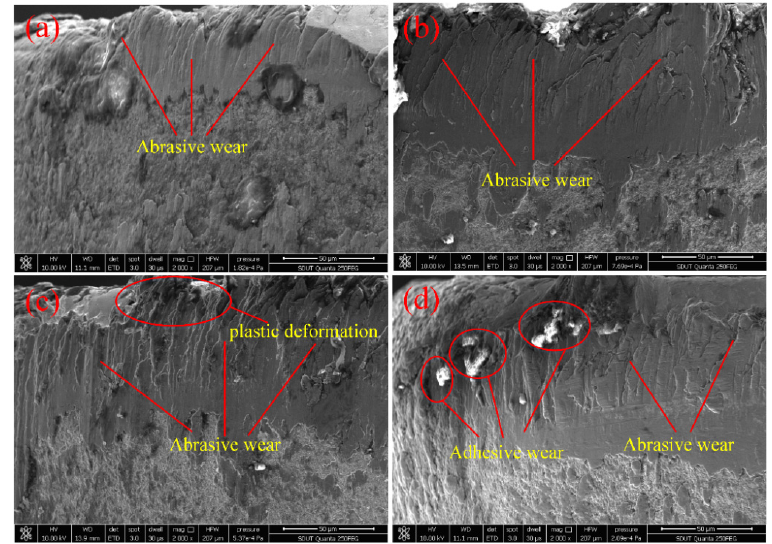
Figure 4. Tool morphology under ultrasonic atomization assisted machining at four cutting speeds: ( a ) 30 m/min, ( b ) 40 m/min, ( c ) 50 m/min, and ( d ) 60 m/min.